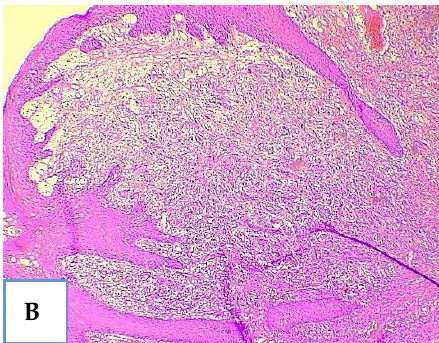
Figure (4-B): Photomicrograph non-lobular PG 10x